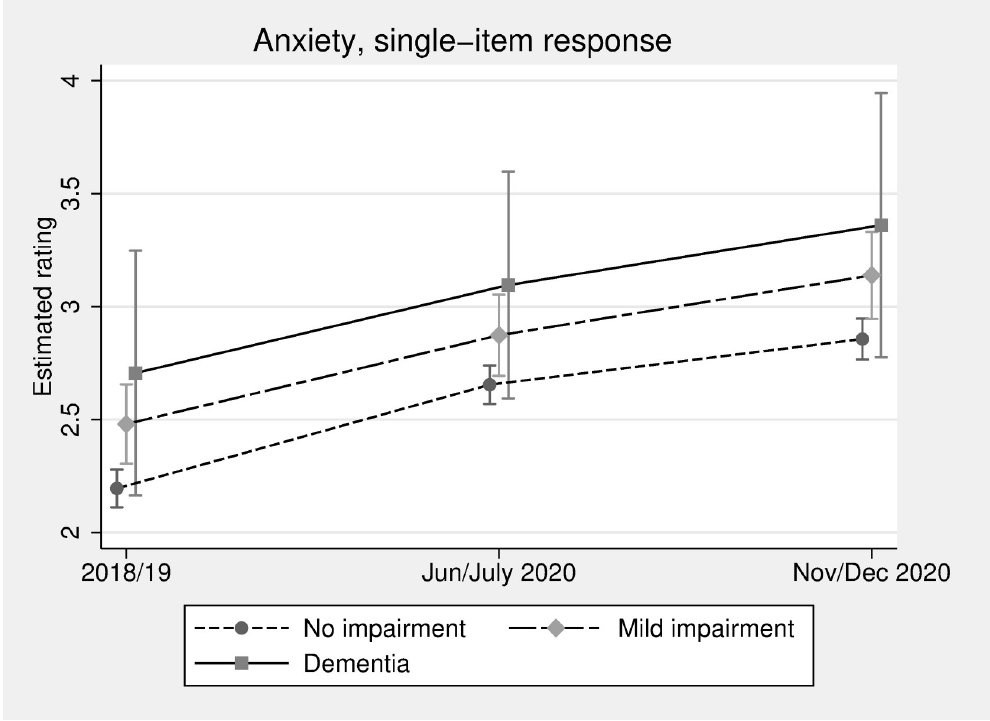
Fig 3. Single-item anxiety rating over time by cognitive function (estimated ratings and 95% confidence intervals, adjusted for all available covariates).